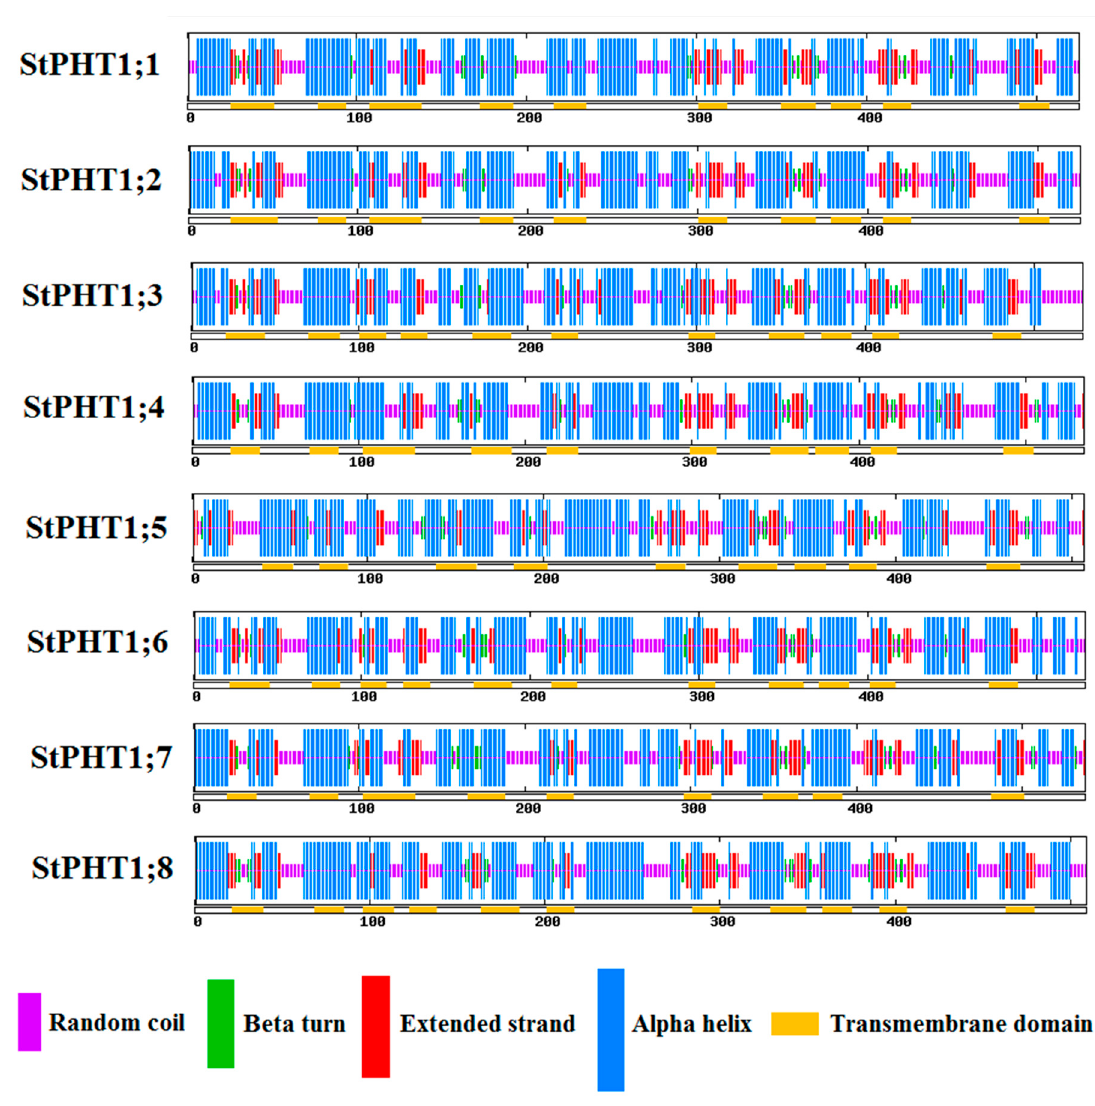
Figure 5. Analysis of the secondary structures of potato PHT1 gene family proteins. Purple boxes indicate random coil, green indicate beta turn, red indicate extended strand, and blue indicate alpha helix. The yellow boxes under each secondary structure box indicate transmembrane domain.